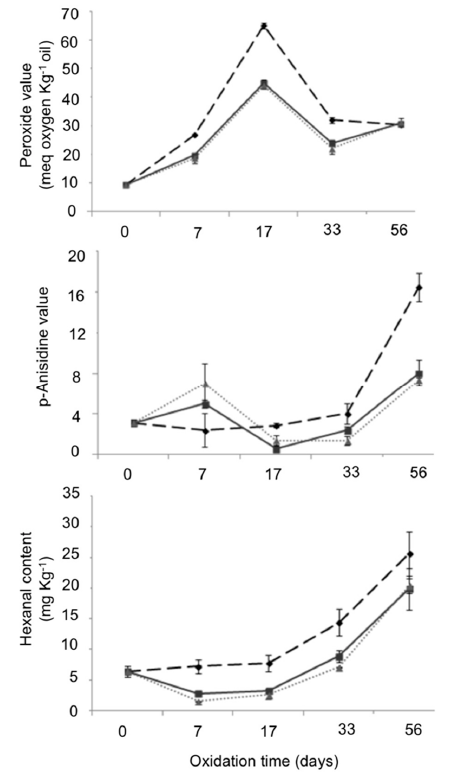
Figure 4. PV, AV and hexanal content for fried almonds packaged with neat PCL ( ), PCL3 ( ) and PCL6 ( ) at 0, 7, 17, 33 and 56 days of oxidative treatment at 40 ° C. Mean ± SD; n = 3. and PCL6 (